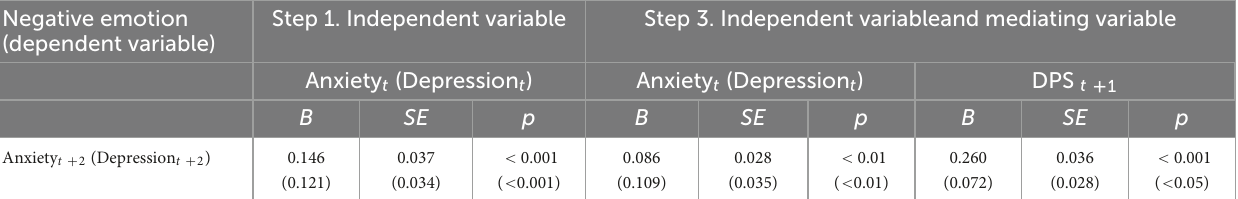
TABLE 2 Step 1 and Step 3 in mediating analysis of Anxiety t , DPS t + 1 , and Anxiety t + 2 are outside the parentheses; mediating analysis of Depression t , DPS t + 1 , and Depression t + 2 are inside the parentheses. Negative emotion (dependent